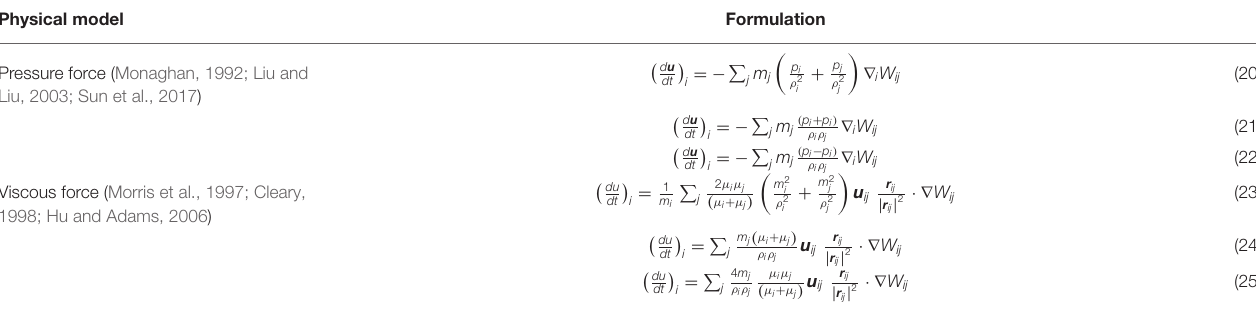
TABLE 2 | Pressure and viscous force models. Physical model